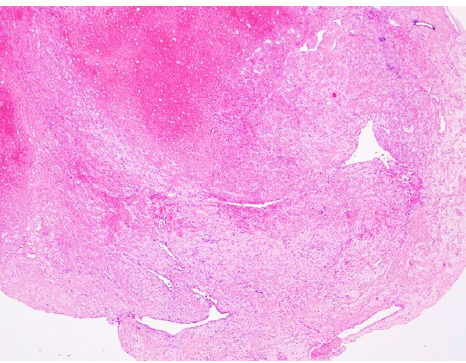
Figure 5. Haematoxylin-eosin coloration. Well-organized thrombus showing recanalization with vascular channels lined by endothelium; HE, ×40.